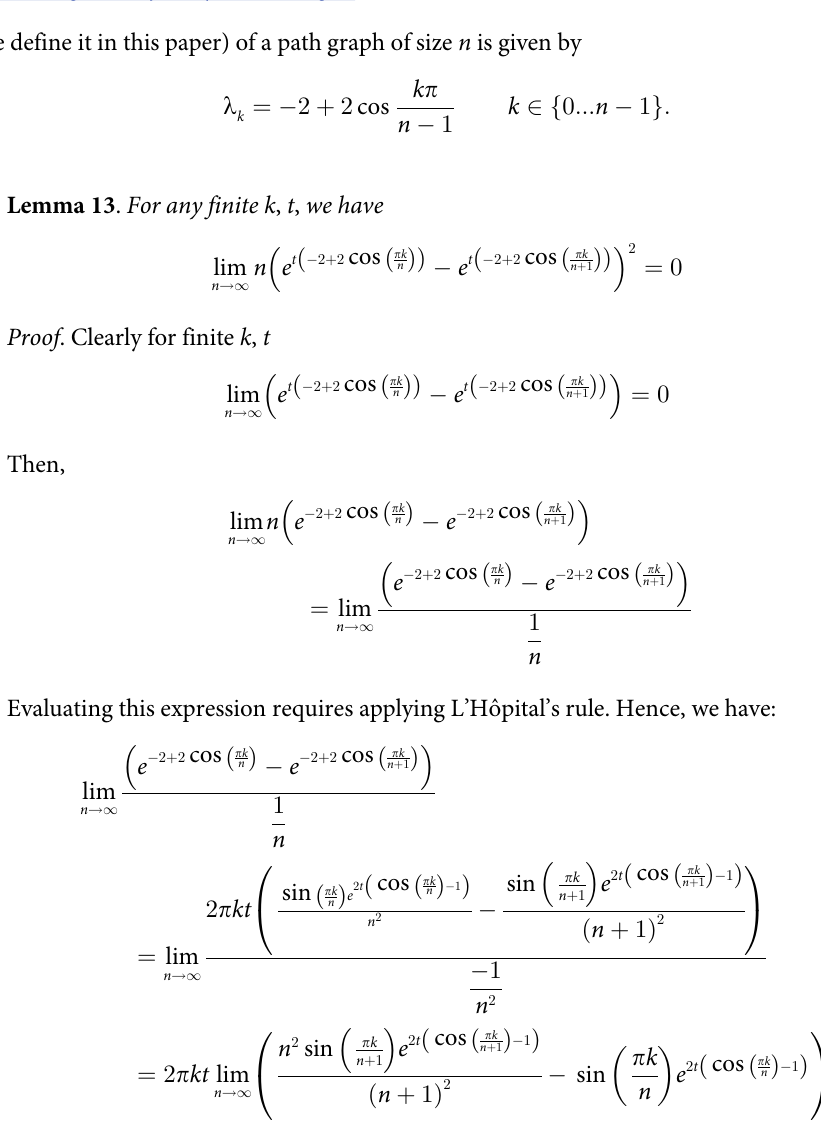
Fig 10. Limiting behavior of D and two parameters as path graph size approaches infinity. All distances were calculated between Path and Path . We plot the value of the objective function, as well as the optimal values of α and n n +1 t , as n ! 1 . Optimal α rapidly approach 1 and the optimal distance tends to 0. Additionally, the optimal t value approaches a constant ( t � .316345), providing experimental validation of the assumption we make in proving Theorem 14.